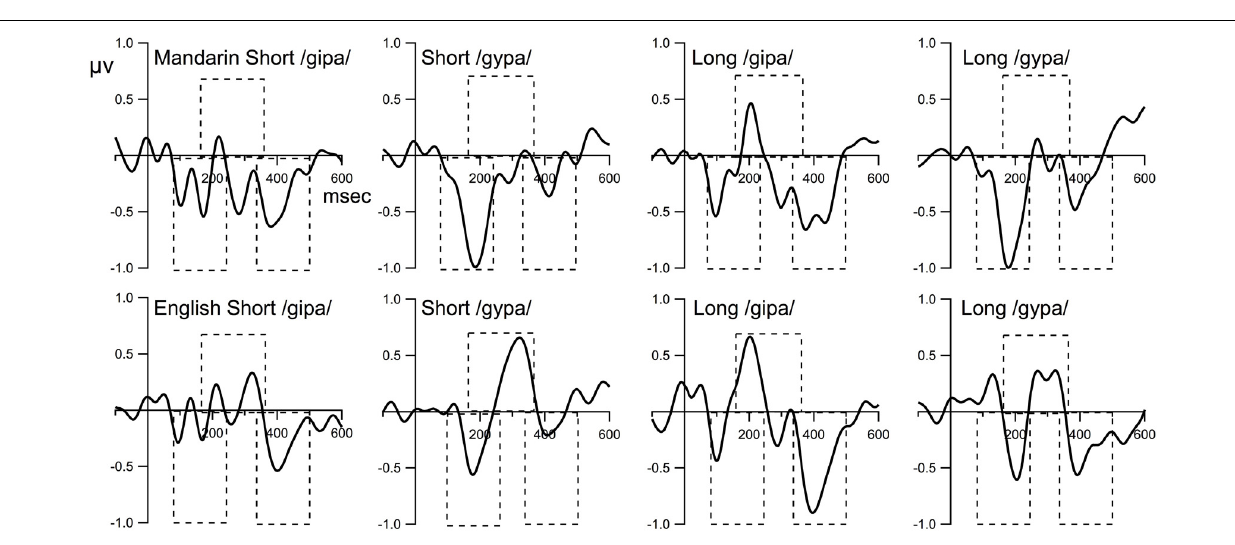
conditions but the English short ISI group for the /gypa/ deviant condition. See Table 2 for the amplitudes and results from the t -tests for each